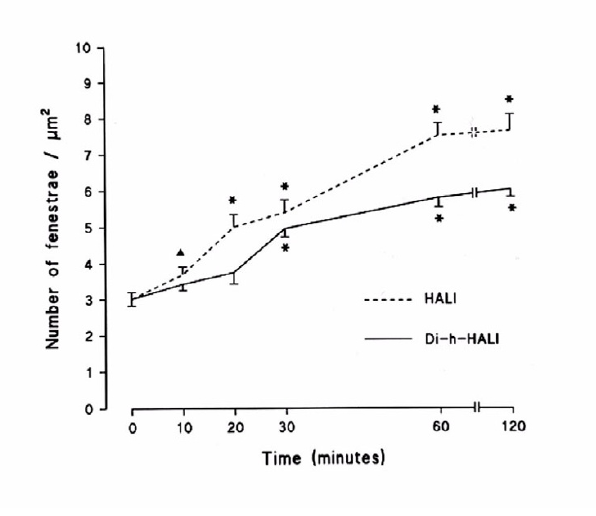
Figure 3 Effect of HALI and di-h-HALI on the number of fenestrae per micrometer squared in time. From this graph, we can conclude that both agents increase the number of fenestrae, although at a different rate and different maxi- mum. Data are means plus or minus S.E.M. of triplicate determinations. Note the significant differences between control LSECs (0 minutes) and treated LSECs, as indicated by asterisks (p < 0.01) or by triangles (p < 0.05) (Mann-Whitney U test, two-sided). No significant difference in the number of fenestrae was observed at the 0.05 confidence level between 60 and 120 minutes of treatment with HALI or